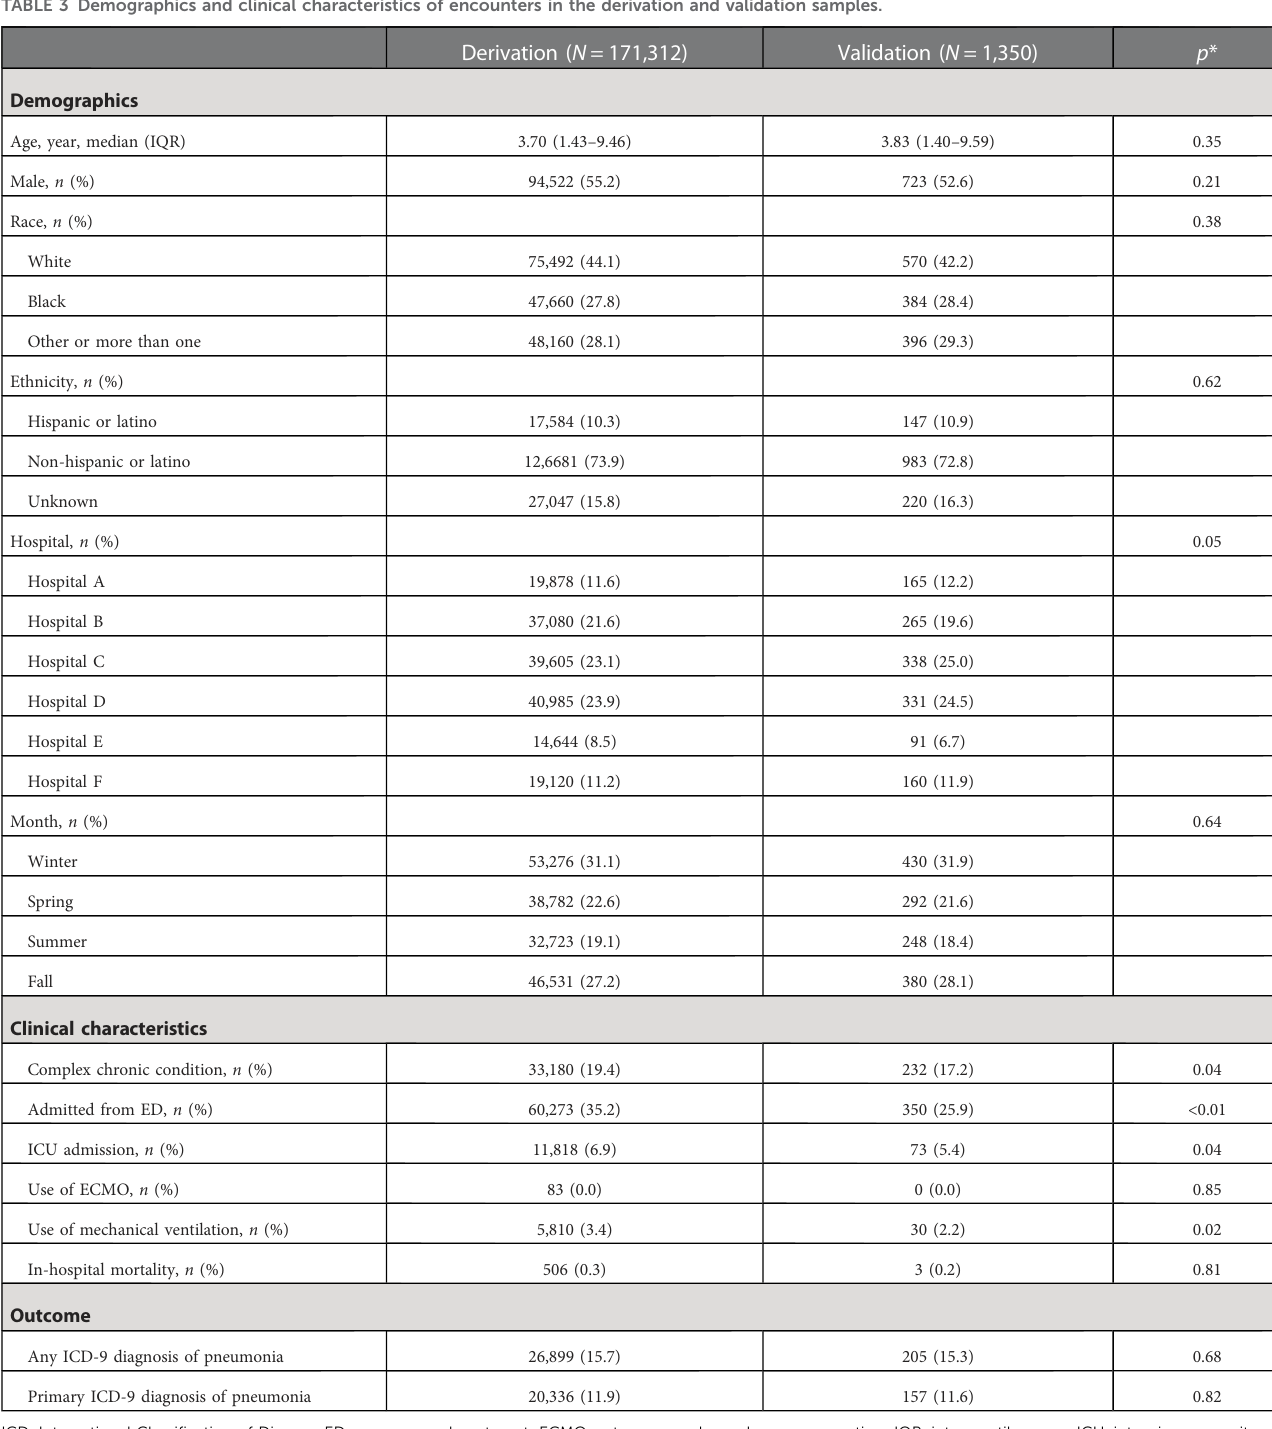
TABLE 3 Demographics and clinical characteristics of encounters in the derivation and validation